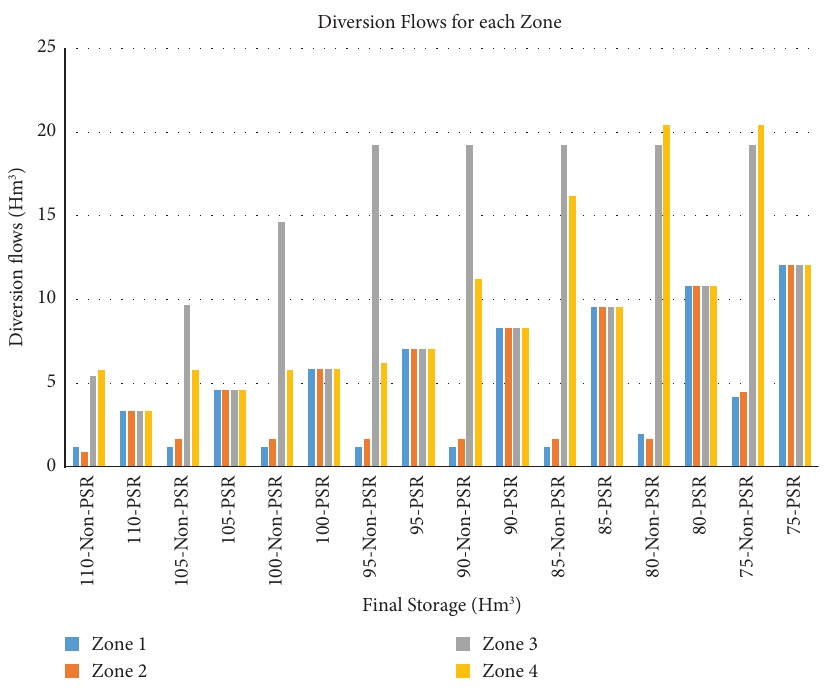
Figure 6: Te diversions for each zone considering non-PSR and PSR